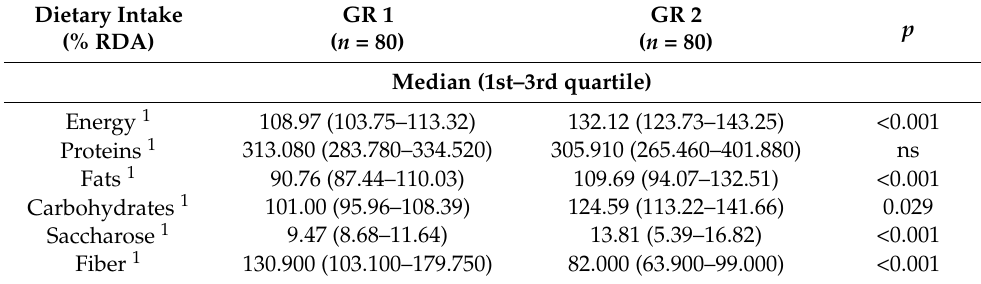
Table 6. Dietary intake in